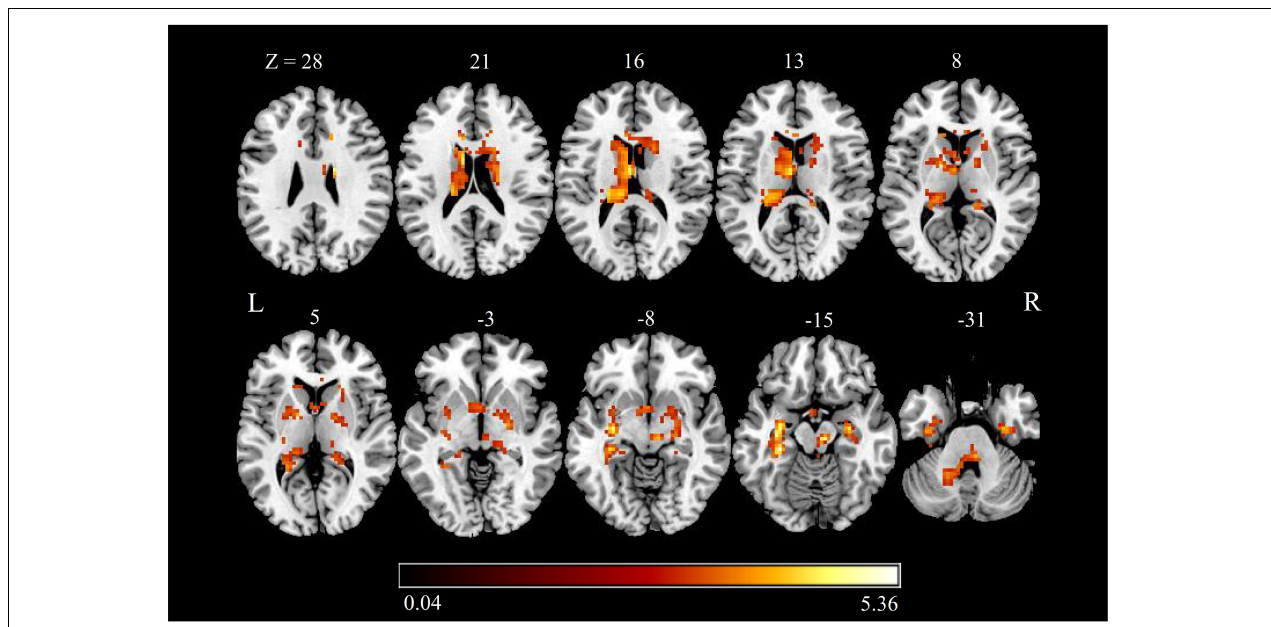
FIGURE 2 | zALFF alterations in patients with CTN. The differences between the CTN patients and HCs were analyzed using a two-sample t -test. The statistical significance level was set at p < 0.05, FDR corrected. Patients with CTN showed significantly decreased zALFF in the bilateral hippocampus, bilateral fusiform FFG, bilateral caudate, left thalamus, bilateral putamen, right pallidum, bilateral PHG, and left cerebellum. The color bar displayed t -values. ALFF, amplitude of low-frequency fluctuation; CTN, classic trigeminal neuralgia; HC, healthy control; FFG, fusiform gyrus; PHG, parahippocampal gyrus.